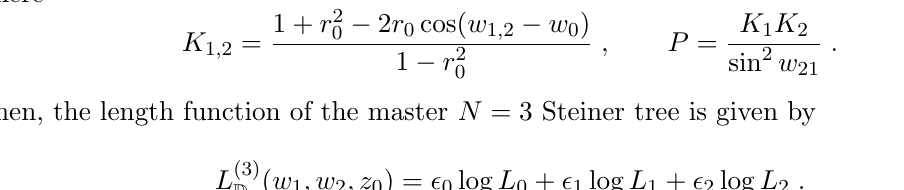
Figure 6 . (a) Master N = 3 Steiner tree with two boundary endpoints and an arbitrary third D , (b) z endpoint z 0 0 = 0 gives the holographic non-ideal N = 3 Steiner tree dual to the general 2 4-point conformal block (c) z 0 @ D gives the holographic ideal N = 3 Steiner tree dual to particular 2 Figure 4 . (a) general N = 3 tree with two boundary endpoints and arbitrary point on the disk (b) 5-point identity conformal block. The associated hyperbolic 3-gons are shown in dashed the third point on the center of the disk (c) the third point on the boundary